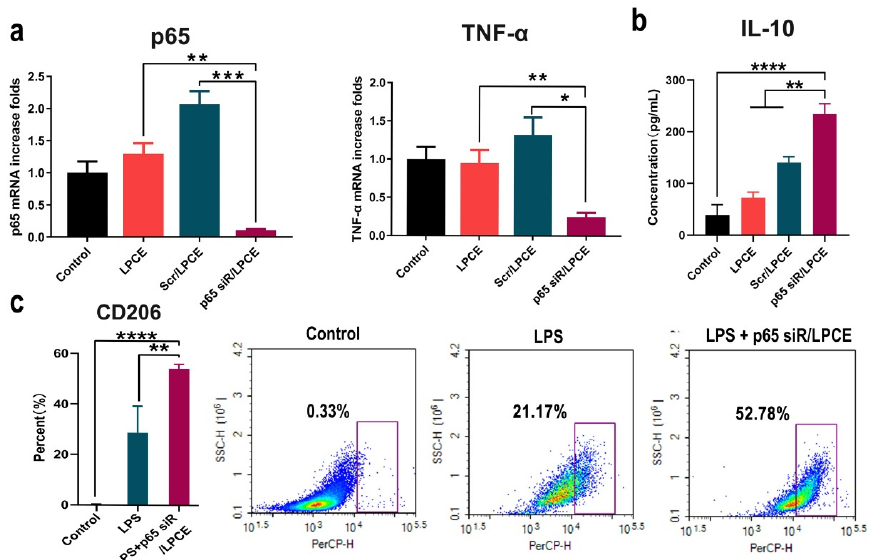
Figure 4. In vitro anti-inflammatory study of p65 siRNA/LPCE complex. ( a ) The levels of p65 mRNA and tumor necrosis factor alpha messenger RNA in RAW264.7 cells after transfection (*** p < 0.001, ** p < 0.01, * p < 0.05). ( b ) The interleukin-10 level detected by enzyme-linked immunosorbent assay in the supernatant of macrophages (**** p < 0.0001, ** p < 0.01). ( c ) The expression of CD206 by flow cytometry in the p65 siRNA/LPCE-treated and untreated groups after stimulation by